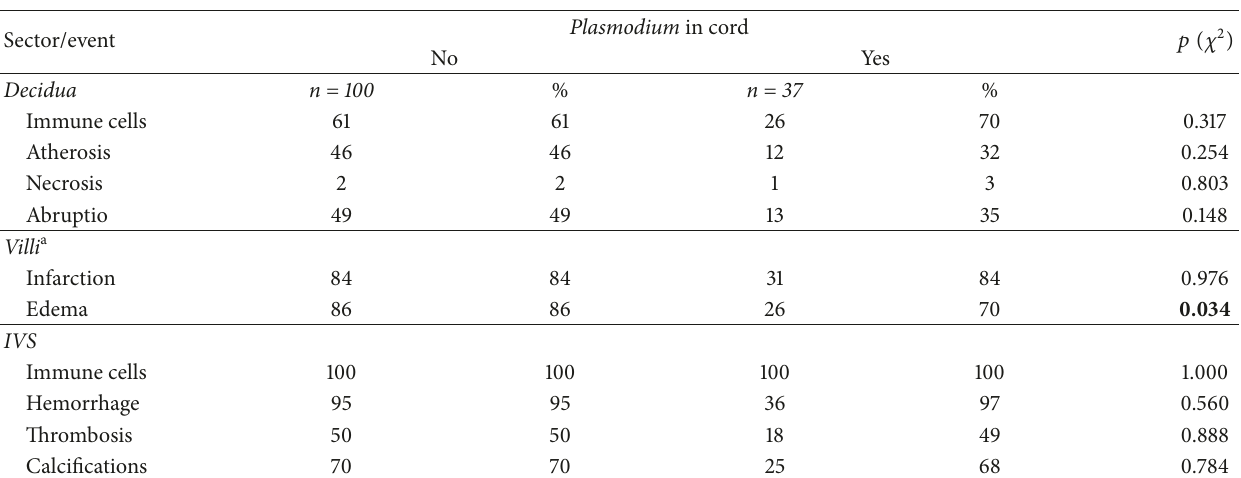
Table 4: Placental histological findings according to the presence of Plasmodium in cord. (a) Prevalence of histologic